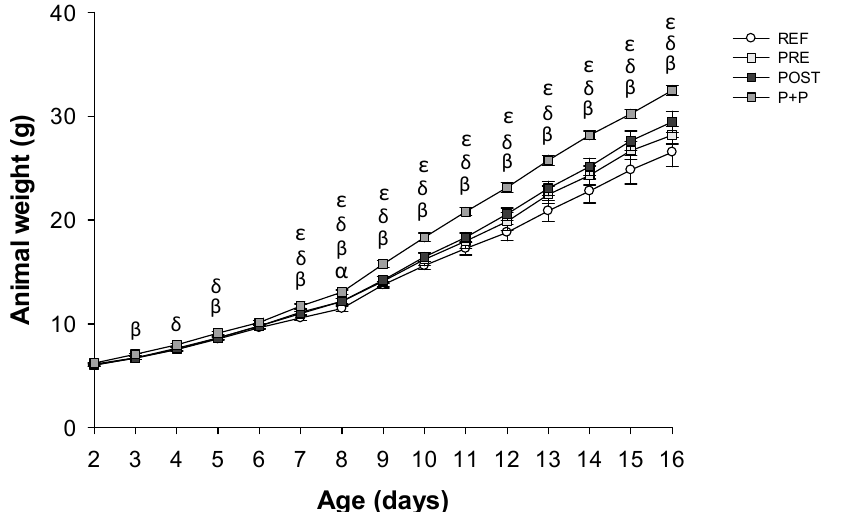
Figure 1. Body weight of pups (g) during the study (from day 2 to day 16 of life). Results are expressed as mean ± SEM (n = 24 animals/group). Statistical differences: α p < 0.05 PRE vs. REF, β P+P vs. REF, δ P+P vs. PRE and ε P+P vs. POST. REF: reference group; PRE: group supplemented with a mixture of scGOS and lcFOS; POST: group supplemented with Lactofidus TM ; P+P: group supplemented with the combination of both. Table 1. Growth-associated measurements and relative weight of organs at the end of the study (day 16 of life).